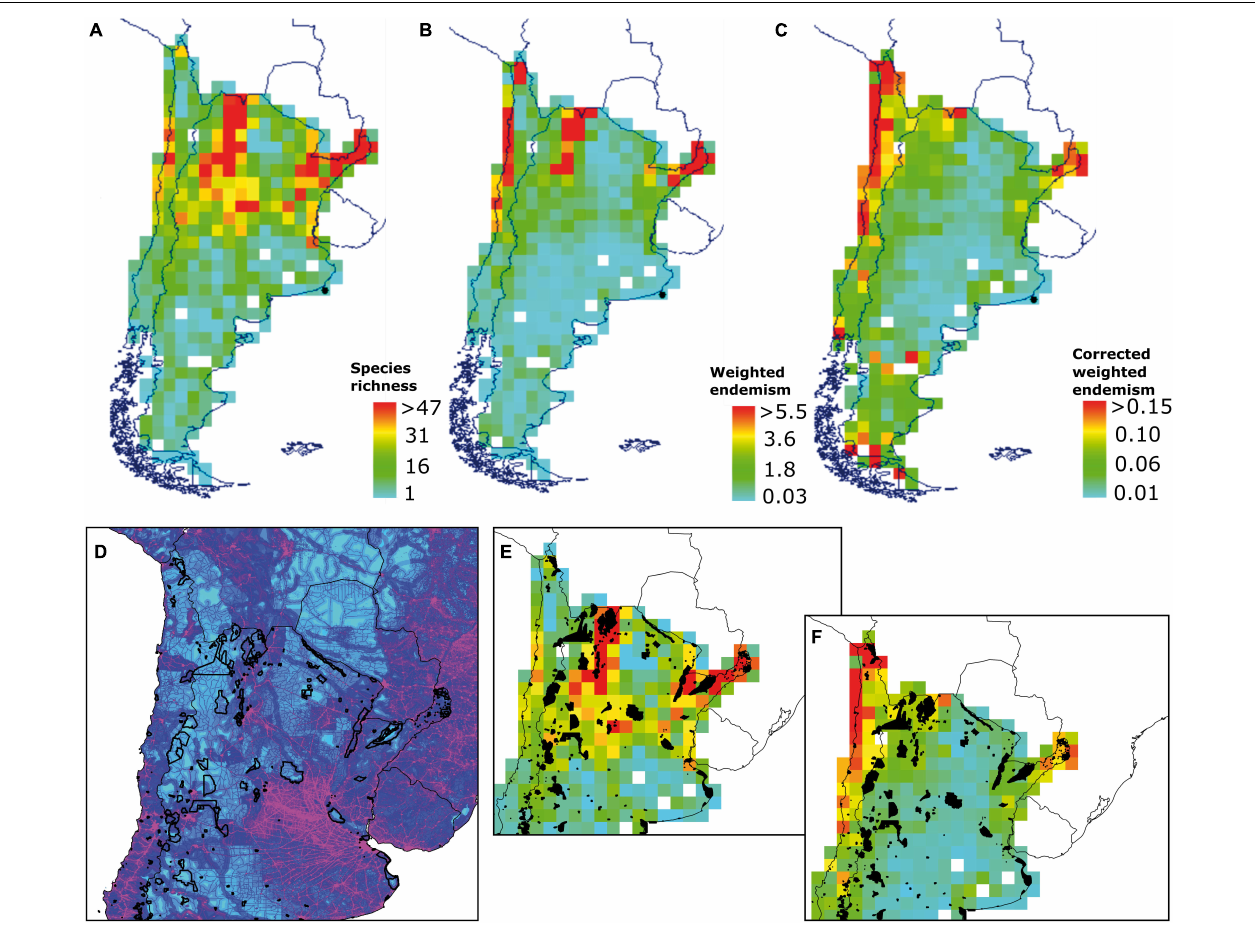
FIGURE 2 | Diversity of Solanaceae species in southern South America, mapped using Biodiverse 3.1 on 1 × 1 degree matrix: (A) Species richness; (B) Weighted endemism; (C) Corrected weighted endemism; (D) A detailed area showing a footprint index and protected areas; (E) Protected areas overlapped with species richness; (F) Protected areas overlapped with corrected weighted endemism. Detailed maps and tables are available as ( Supplementary Material